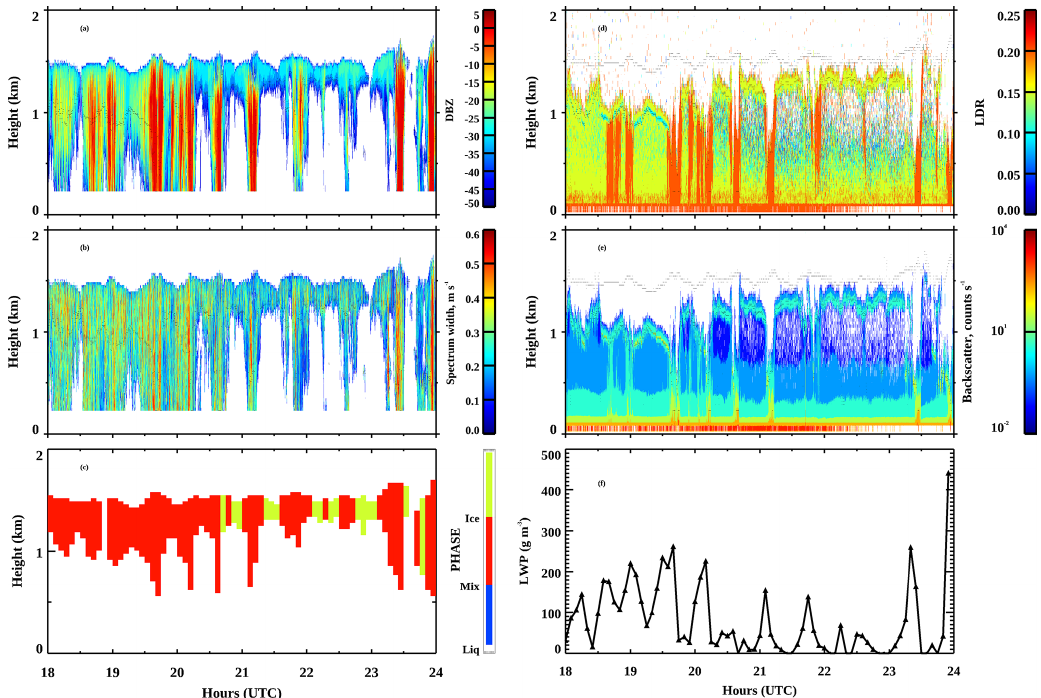
Figure 6. A case study that shows our phase classification (a, b, c) and micropulse lidar (MPL) linear depolarization ratios (LDRs) and backscatter. W-band (95GHz) ARM Cloud Radar (WACR) reflectivity is shown in panel (a) , and spectrum width is shown in panel (b) . Correspondingly, the phase classification is shown in panel (c) , the MPL LDR is shown in panel (d) , backscatter is shown in panel (e) , and MWR-derived LWP is shown in panel (f) .